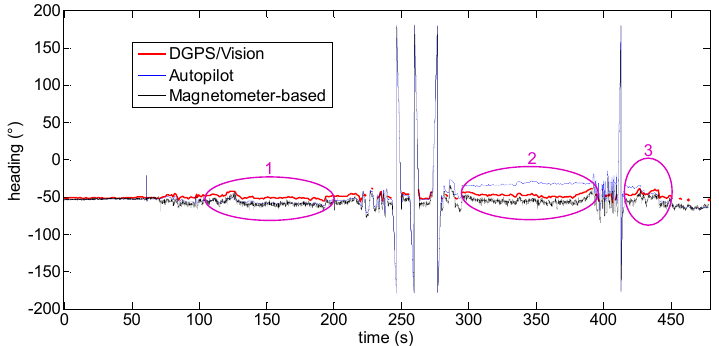
Figure 15. Heading angle as a function of the flight time (Test 1).